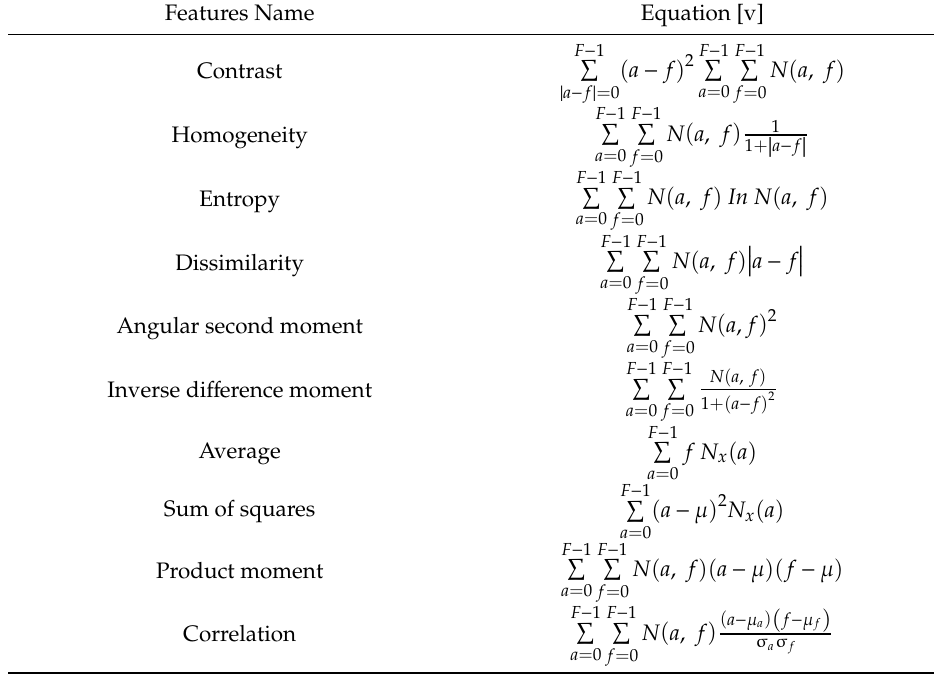
Table 2. Textural features equations suggested by [23].